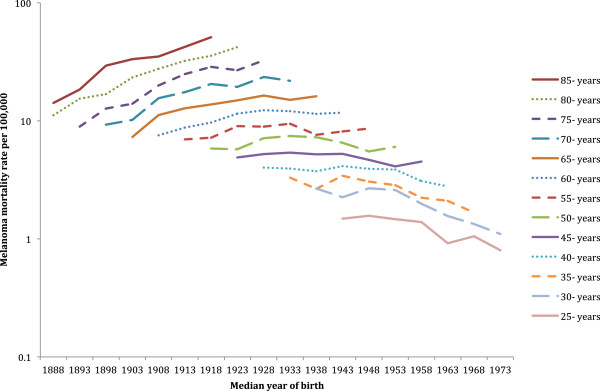
Australian melanoma mortality by 5-year age group and median year of birth. Both sexes combined. (y-axis on log scale).